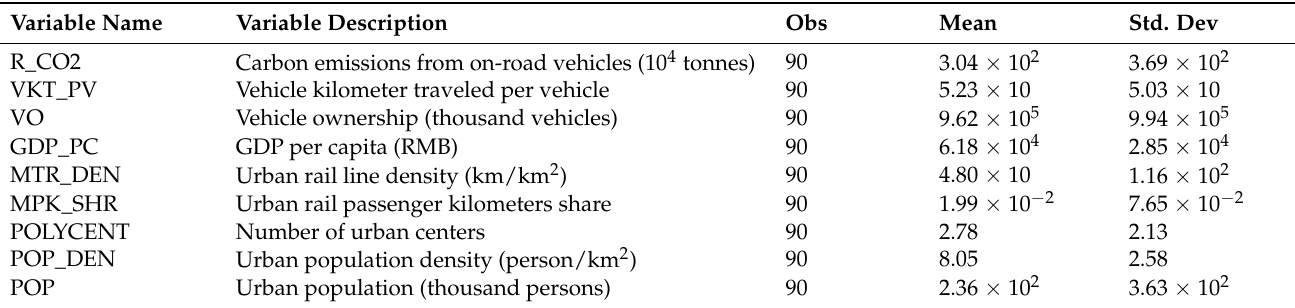
Table 2. Variable list and descriptive statistics.